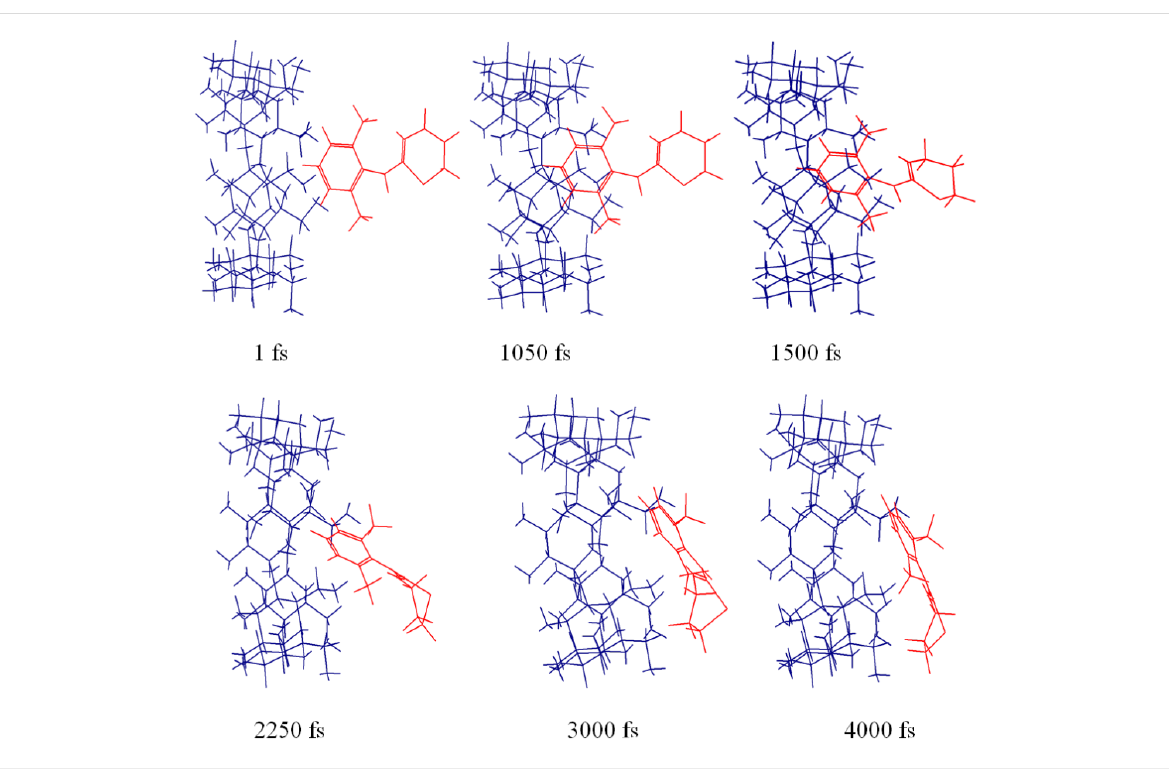
Figure 9: Snapshots showing the inclusion of xylazine into the β -CD cavity as obtained in the MD trajectory from narrow